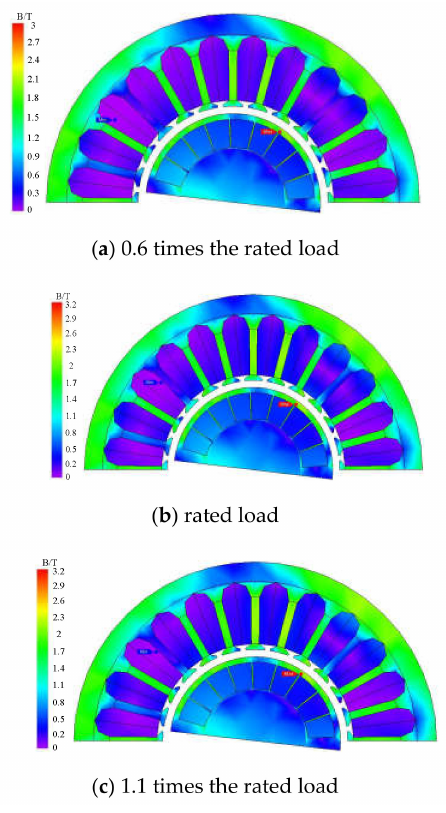
Figure 9. Magnetic induction intensity distribution of motor in multi-load